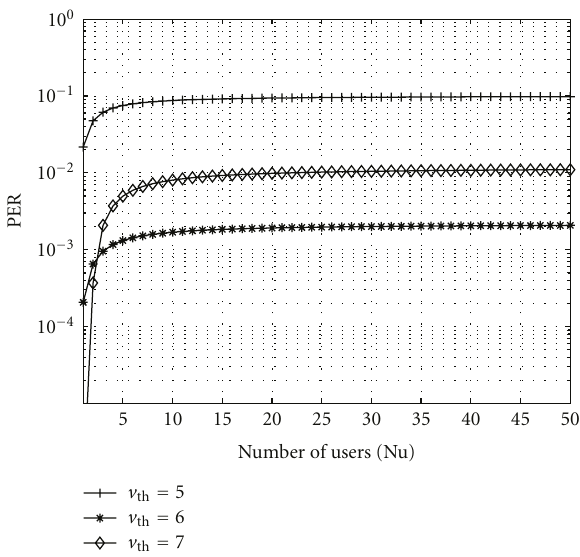
Figure 10: Influence of v th on 8-PIM PER performance when the number of users increases, for w = 10 and E b /N 0 = 15dB.